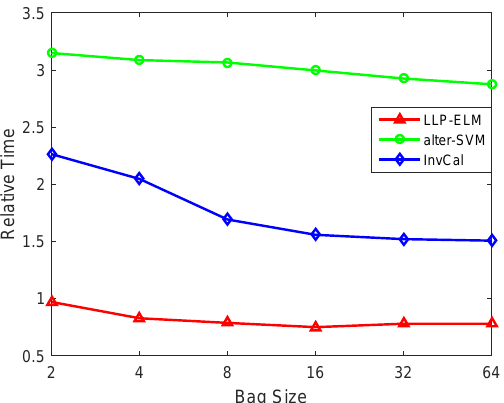
Figure 5. The mean relative time for the classification of different methods on the machine learning datasets. Specifically, the x-axis represents different bag size and y-axis is the relative